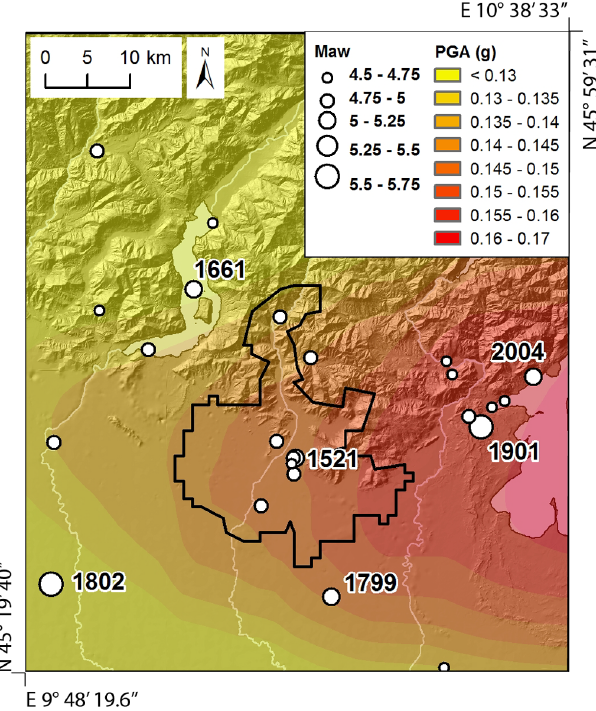
Fig. 2. Values of peak ground acceleration PGA, in g, with ex- ceedance probability of 10% in 50yr, and location of historical earthquakes. Magnitude is expressed as Maw, momentum magni-